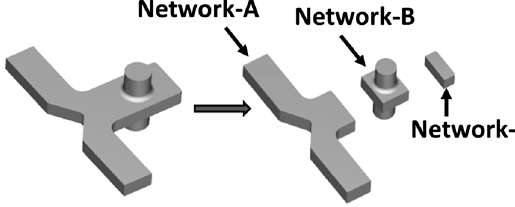
FIG. 2. The rf polarizer divided into each submatrix for cascade analysis.